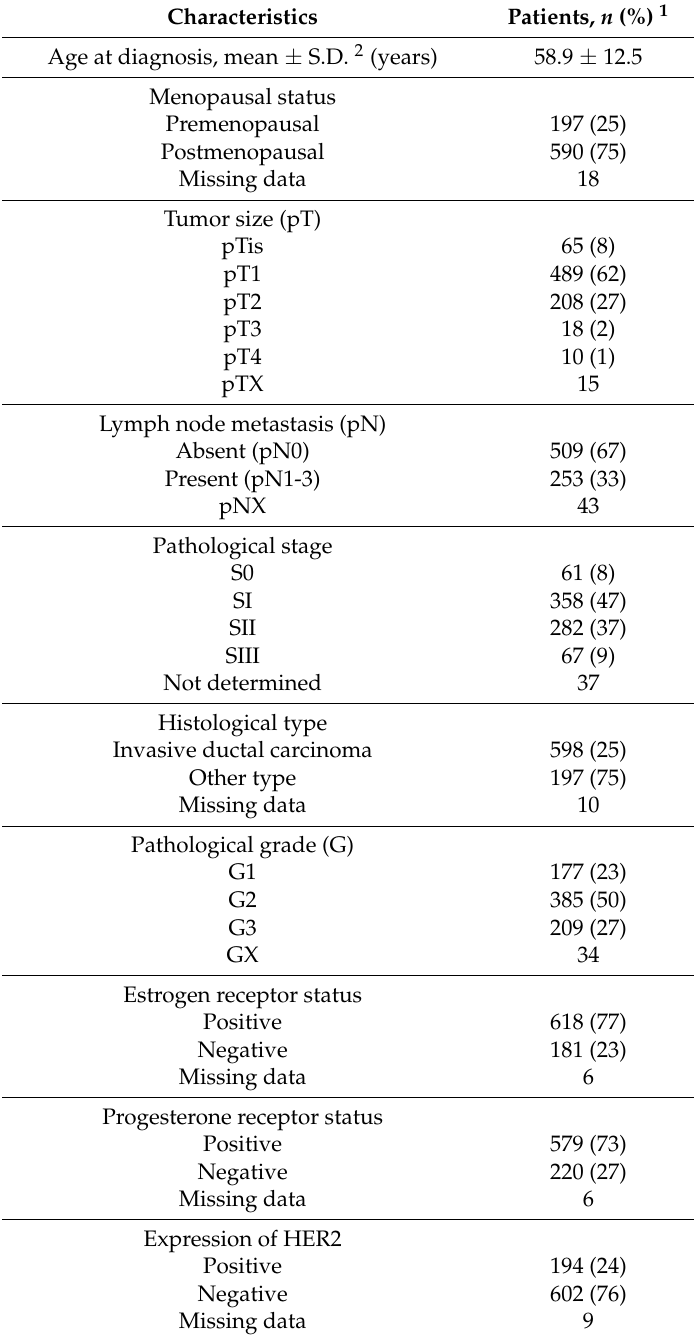
Table 6. Clinical data of patients in the validation